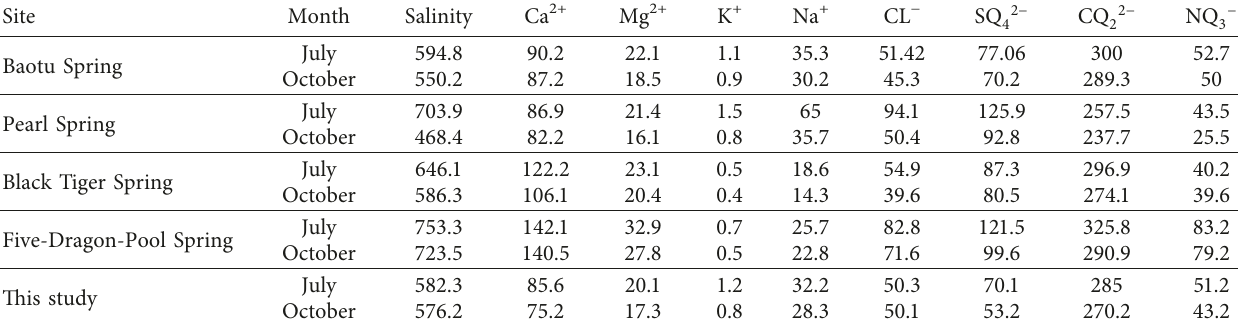
Table 1: The quality of the spring water in Jinan city